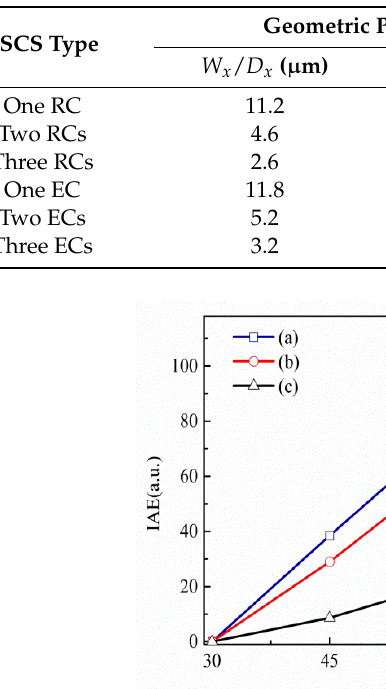
Table 1. Better relative IAEs and geometric parameters for the six ESCSs.